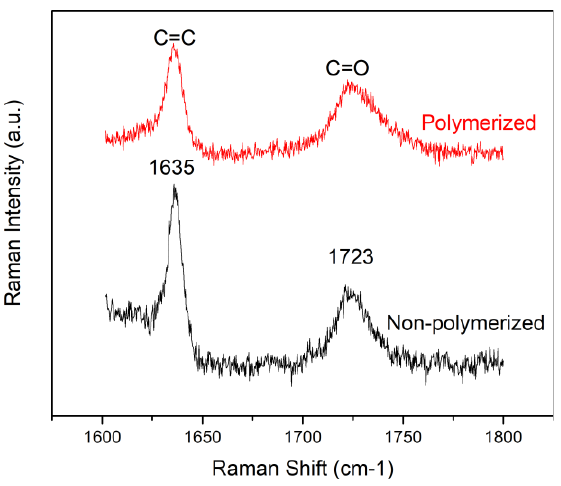
Figure 11. Raman spectrum of the polymerized and non-polymerized photocompositions (4Met- BAC and PETA). The spectra are shifted along the vertical axis for comparison. The black curve corresponds to the spectrum of the non-polymerized photocomposition. Red - for polymerized one.